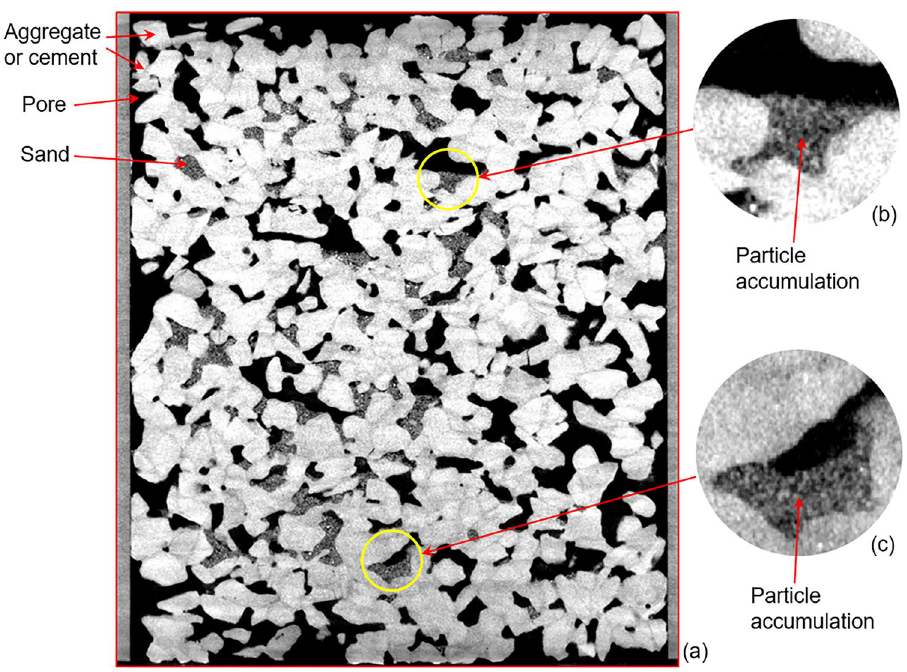
Figure 11. The CT image of the medium sand-clogged sample after all 30 washing cycles: ( a ) vertical image; ( b ) particle accumulation-clogging; and ( c ) particle